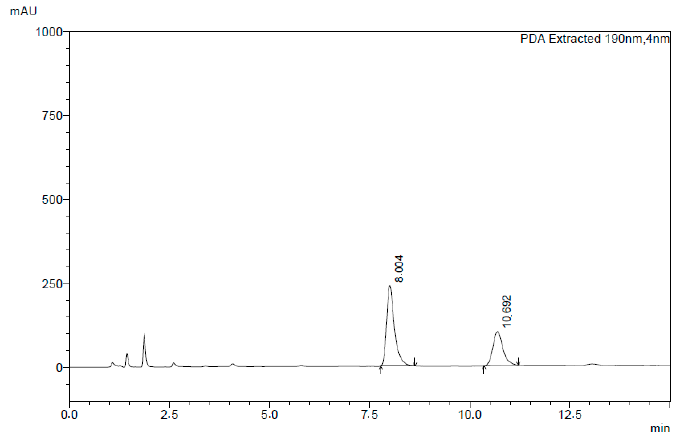
Figure 7. Chromatogram of clotrimazole and itraconazole obtained in the robustness studies.